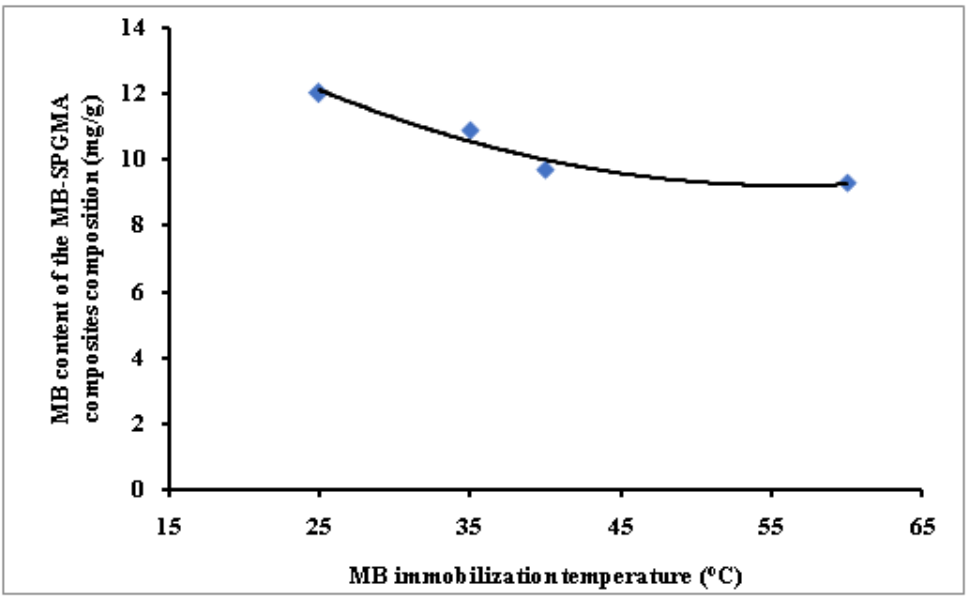
Figure 5. Effect of the immobilization temperature on the MB content of the MB-SPGMA composites composition.